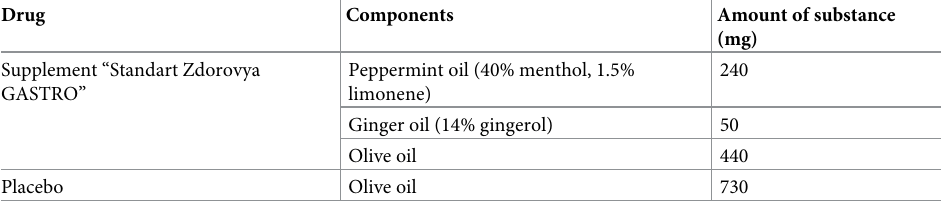
Table 2. Components in the supplement and placebo